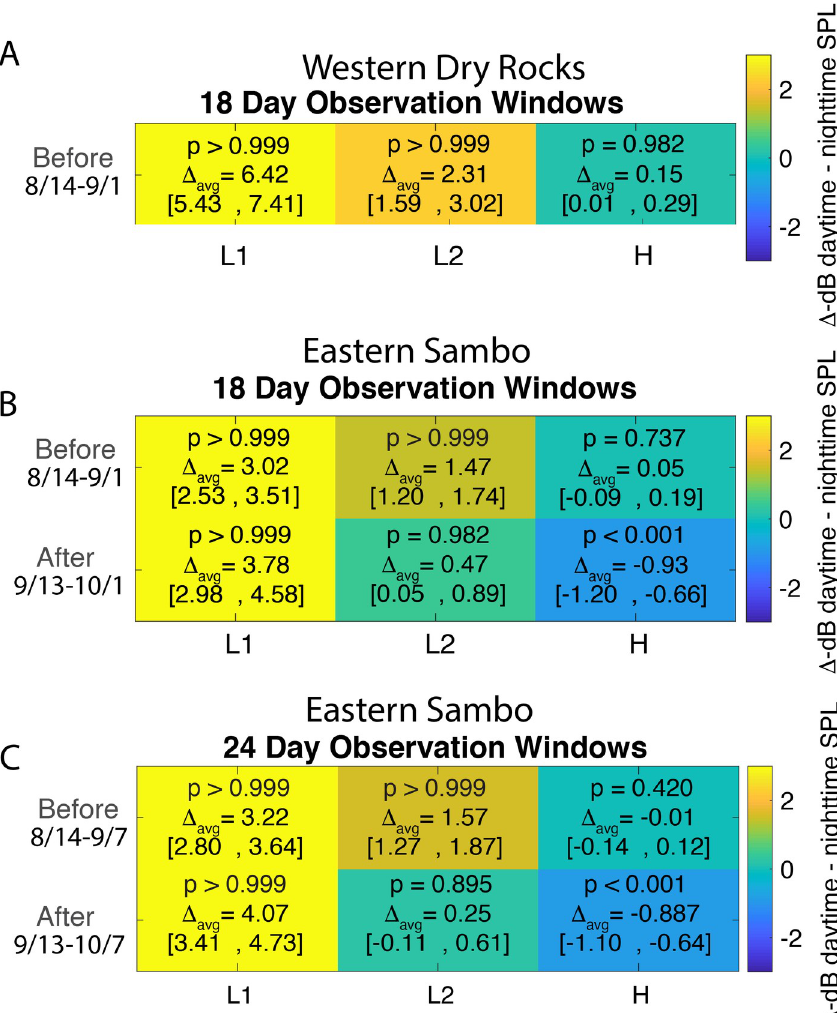
Fig 9. Pairwise bootstrap analysis results. Pairwise bootstrap (n = 5000) of mean differences, 95% confidence, and probabilities (p) daytime mean SPL > nighttime mean SPL for 18-day observation window at Western Dry Rocks (A) and Eastern Sambo (B). An additional pairwise analysis is given for Eastern Sambo for 24-day observation window (C). Frequency bands are denoted as follows: L1 low frequency (50-300Hz); L2 low frequency (1,200–1,800Hz); H, high frequency (7,000–20,000Hz). The color-bar represents the change in SPL (dB) between daytime-nighttime paired SPLs, with the 95% confidence range for decibel differences given in brackets. High p values and positive changes in decibel levels indicate periods when the average daytime SPL was higher than average nighttime SPL. Low p values and negative changes in decibel levels indicate periods when the average nighttime SPL was higher than average daytime